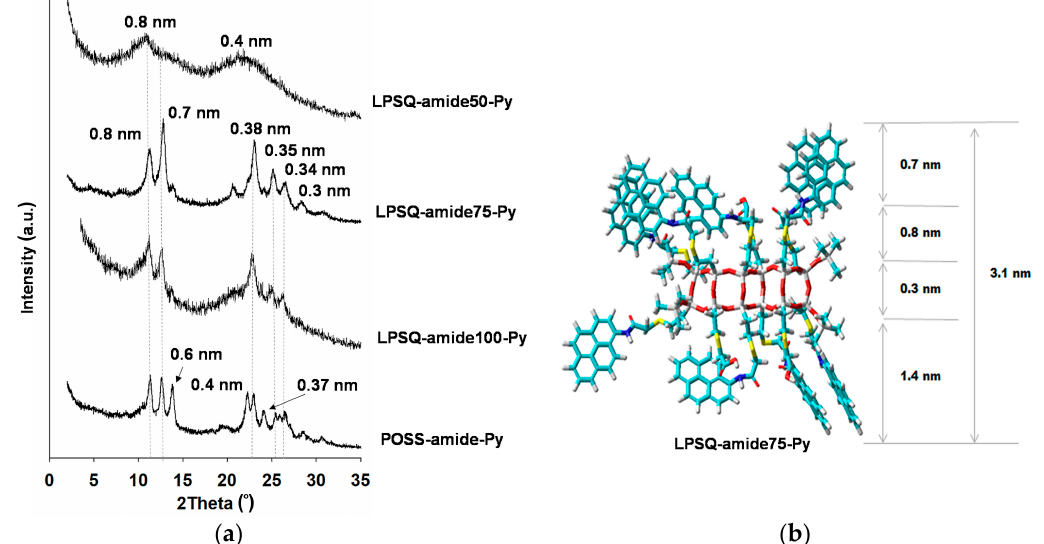
Figure 6. ( a ) WAXS diffractograms of thin films of LPSQ-amide-Py and POSS-amide-Py cast on silicon plates from DMF solutions; ( b ) HyperChem [37] calculated structure for LPSQ-amide75-Py.